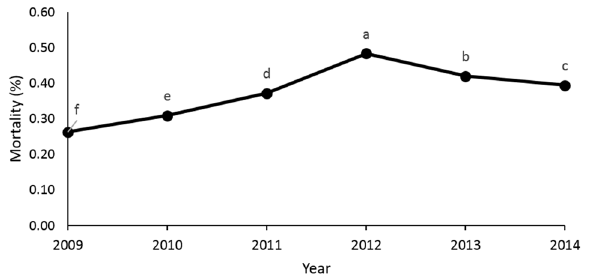
Figure 1. Trends in the transport-related mortality in broiler chickens in the period from 2009 to 2014. a-f Mortality in columns with different superscripts differ significantly